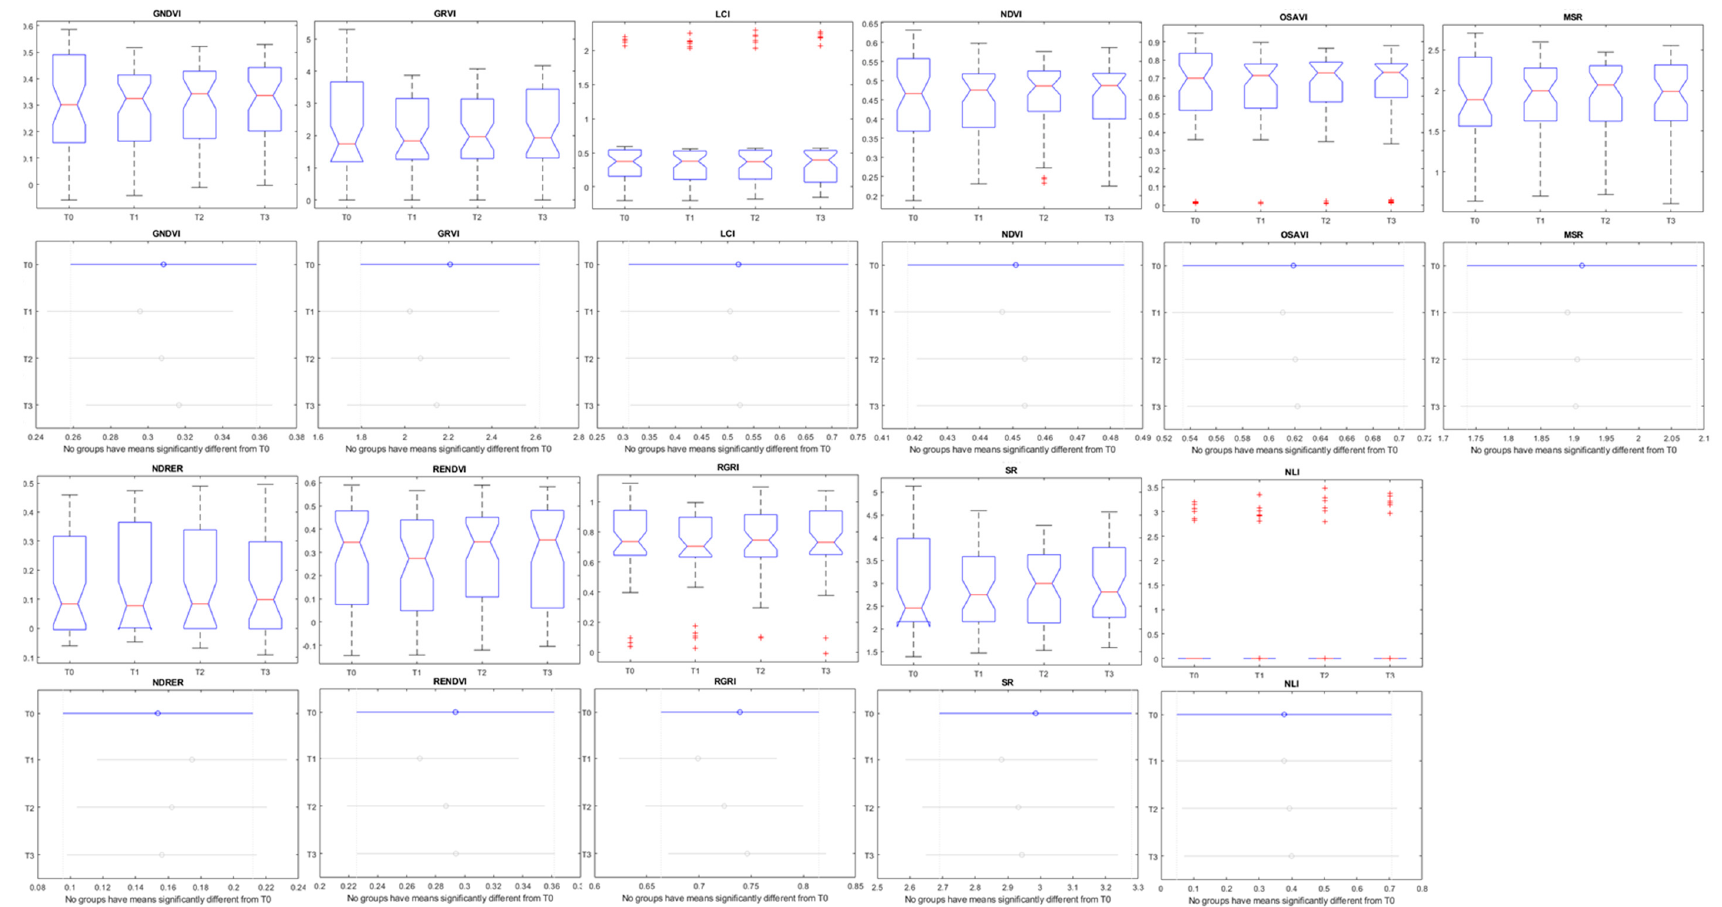
Figure 10. Boxplots and Tukey Test with 99% of probability using all data (50 days) representing vegetation indices of tomato plants with different levels of organic fertilization. T0, T1, T2, and T3 were the four groups of plants treated with different amounts of fertilizer and vermicompost (see Section 2).